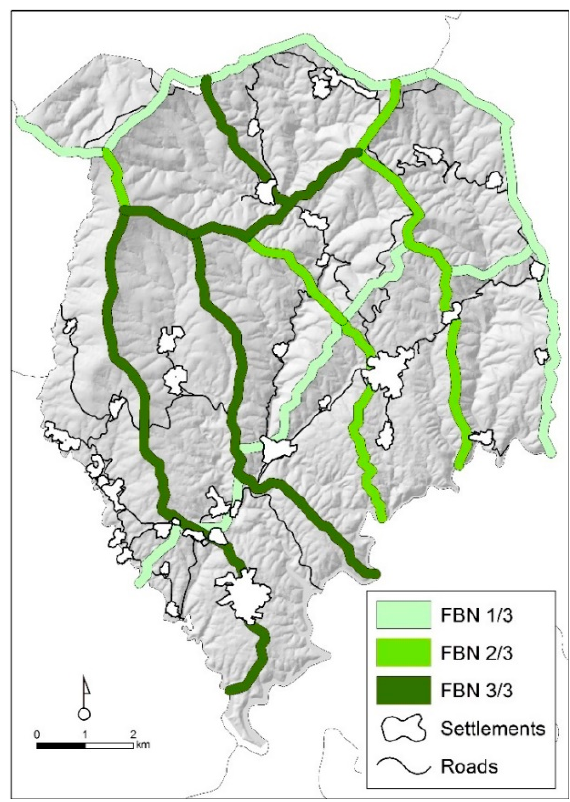
Figure 4. Fuel break network (FBN) planned for Alvares, in the three priority levels: FBN 1/3 (first priority, to decrease the area traveled by large fires), FBN 2/3 (second priority, to protect buildings and infrastructures), FBN 3/3 (third priority, to isolate potential fire ignition spots).